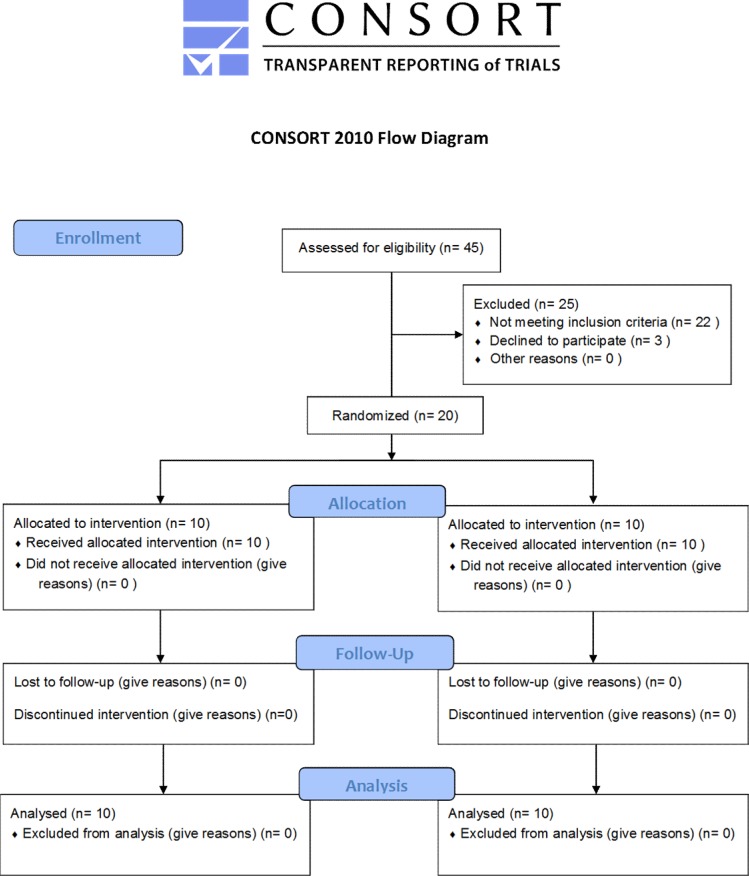
CONSORT flow diagram.